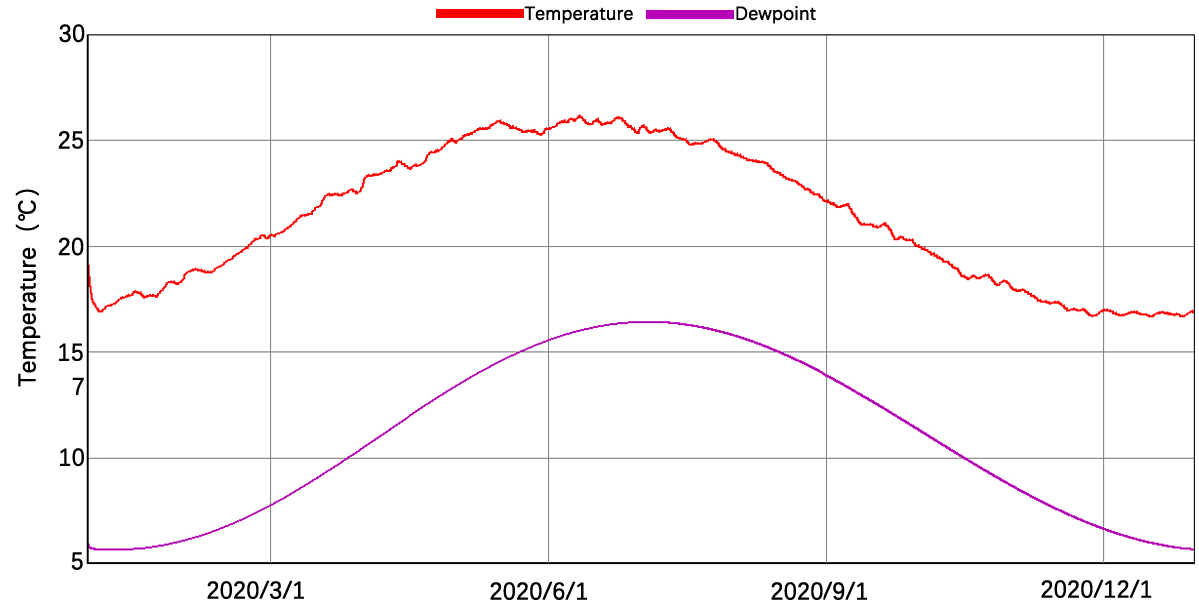
Figure 19. Dewpoint and temperature of monitoring point 4.